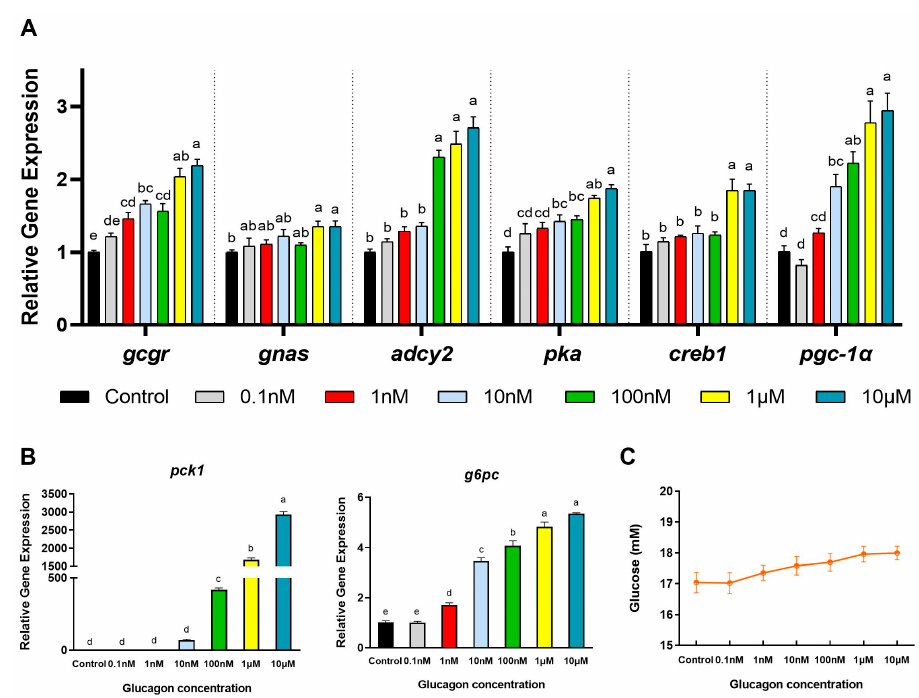
Figure 3. Dose-dependent e ff ects of glucagon treatment on the mRNA levels of genes in hepato- cytes and glucose concentration in the medium. ( A ), qPCR analysis of the mRNA levels of gluca- gon pathway-related genes ( gcgr ; gnas ; adcy2 ; pka ; creb1 ; pgc-1 α ) in hepatocytes in response to glu- cagon treatment at di ff erent doses or DMSO (24 h). ( B ), qPCR analysis of the mRNA levels of glu- coneogenic genes ( pck1 and g6pc ) in hepatocytes in response to glucagon treatment at di ff erent doses or DMSO (24 h). ( C ), Glucose concentration in the medium in response to glucagon treat- ment at di ff erent doses or DMSO (24 h). All data are expressed as mean ± SE, n = 3, one-way ANOVA with Tukey post-hoc test. Values with di ff erent le tt ers mean statistical di ff erences ( p < 0.05).